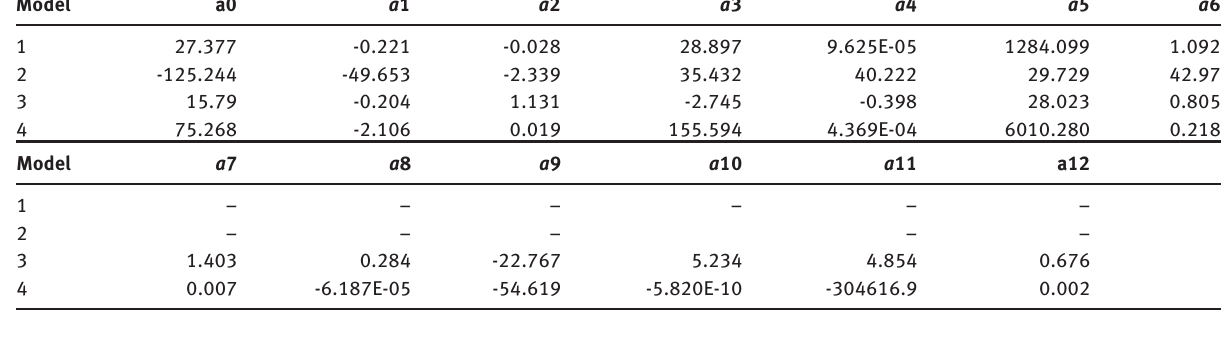
Table 4 Evaluated coefficients of regression models.